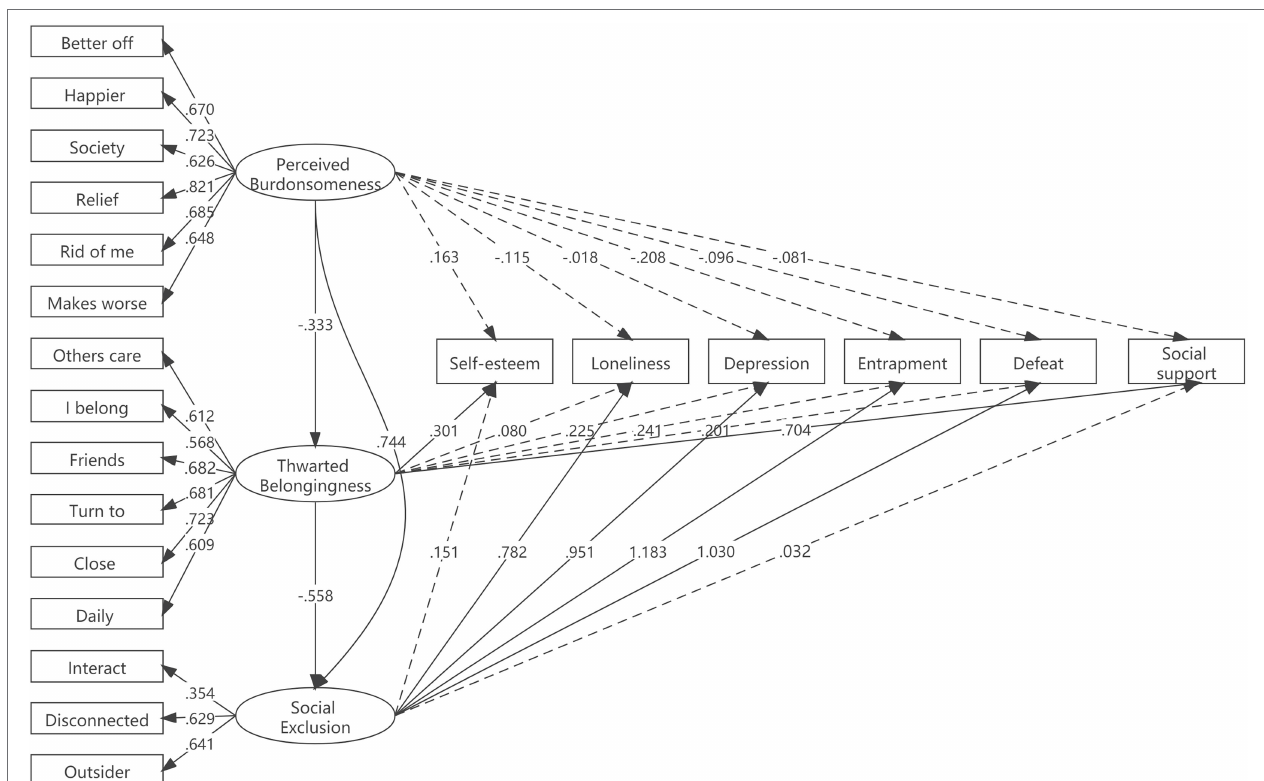
FIGURE 2 | Structural equation model results examining convergent and divergent